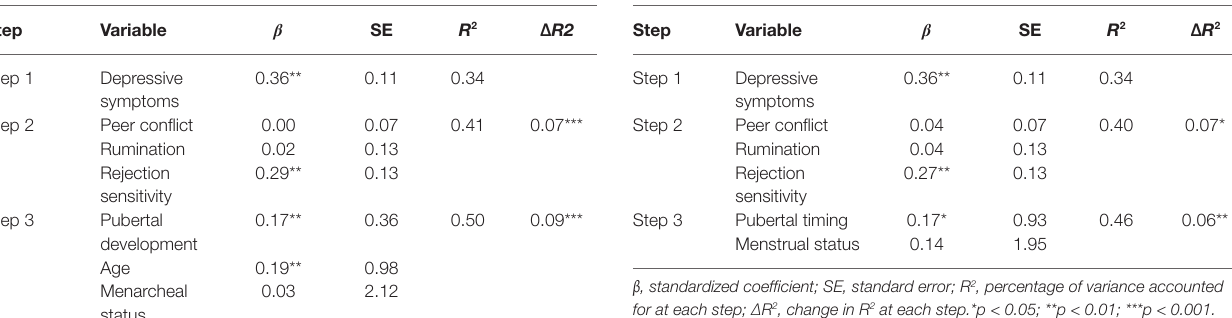
TABLE 3 | Pubertal timing regression estimates predicting Time 2 depressive symptomology.